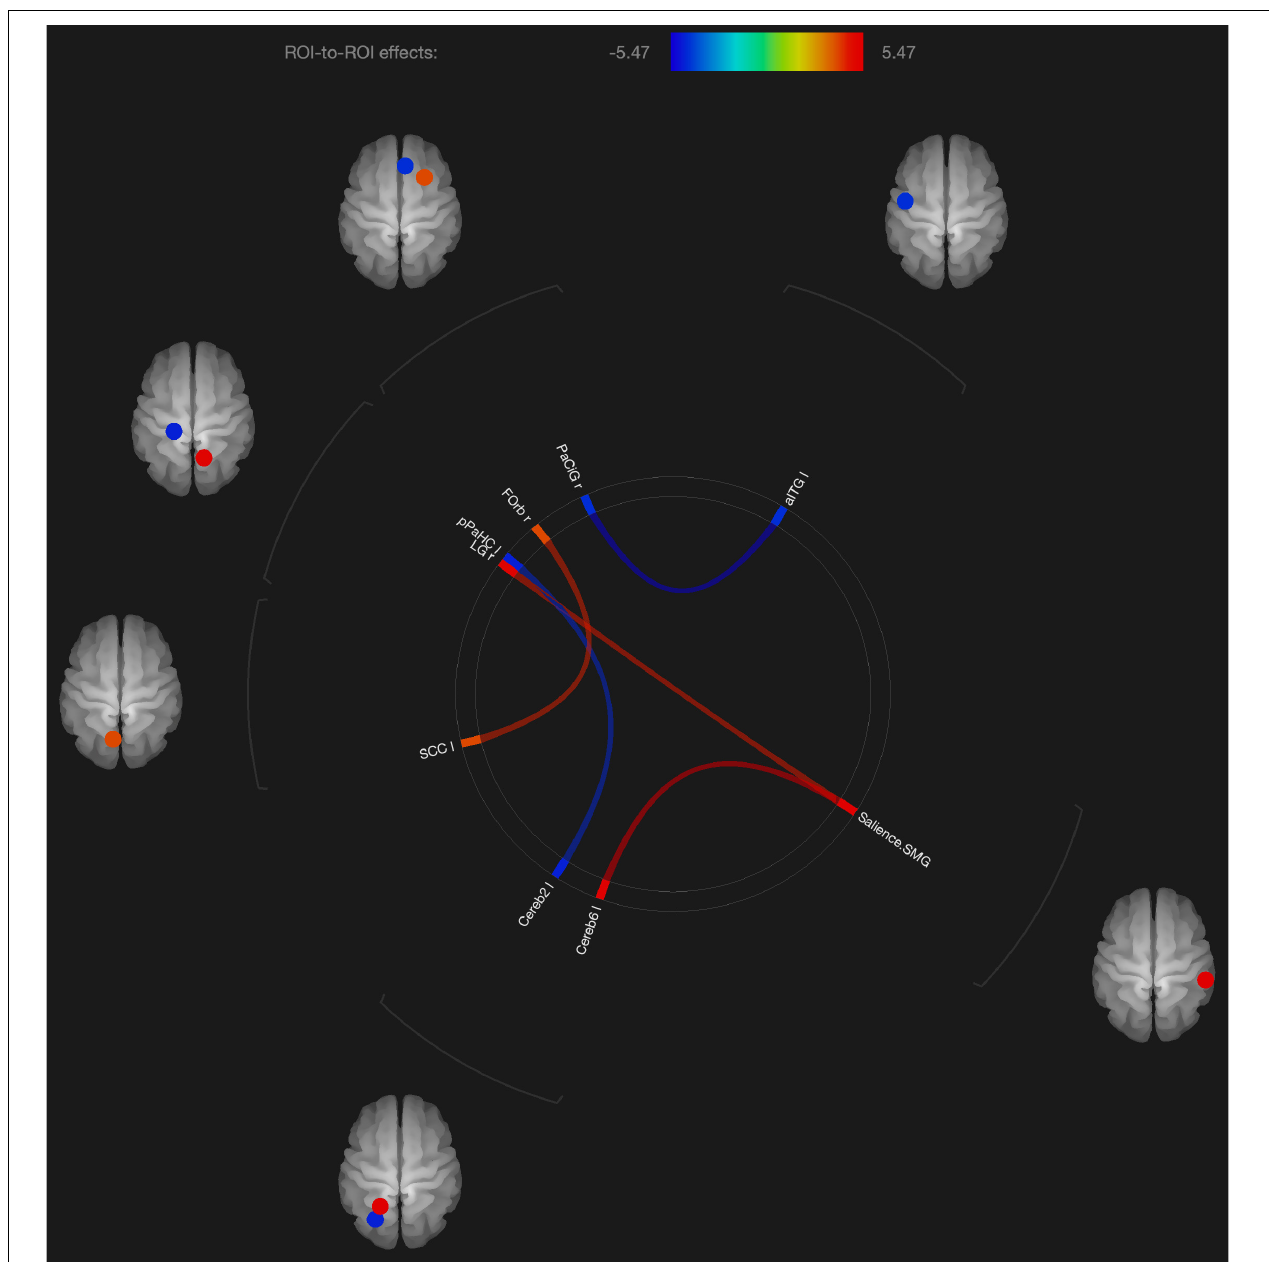
FIGURE 3 | Visualization of ROI-to-ROI connections comparing orgasmic meditation (OM) and neutral groups among males, p -FDR corrected) < 0.05.